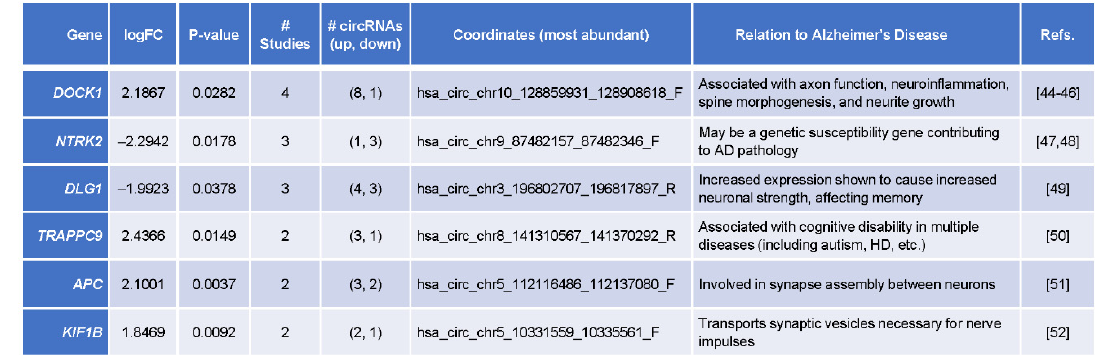
Figure 7. Differentially abundant circRNAs shared across studies, originated from AD-associated gene loci. Table summarizes circRNAs differentially abundant in brain samples from AD relative to normal individuals, produced from parent RNAs that were transcribed from gene loci linked to AD pathology. The gene names (‘ Gene ’), relative levels and significance for circRNAs displaying the greatest differences in abundance (‘ logFC ’, ‘ p-value ’), number of studies in which the circRNAs were found differentially abundant (‘ # Studies ’), the circRNAs more abundant (up) and less abundant (down) in AD relative to normal, the genomic location (‘ Coordinates ’), and the ‘ Relation to Alzheimer’s Disease ’, and the pertinent references are indicated [44–52].